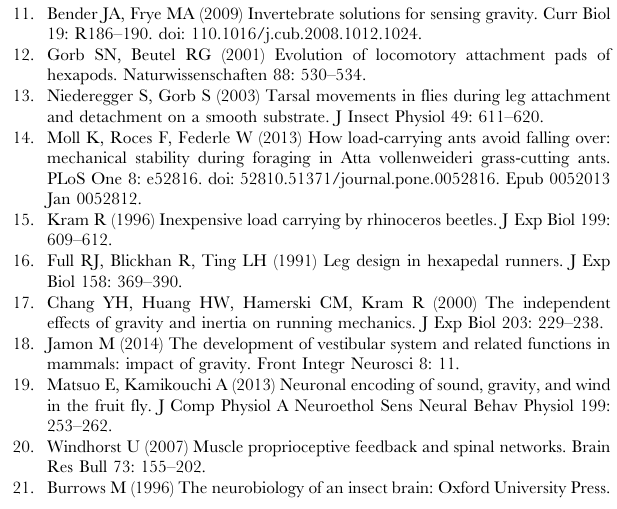
Figure S1 Gait parameters by walking orientation. (A–E) Each column corresponds to a walking orientation compared to upright controls. Graphical fits are also represented. (A) Swing speed. (B) Step length. (C) Swing duration. (D) Stance duration. (E) Duty factor. (TIF) Figure S2 Stance linearity and footprint alignment by walking orientation. Each column corresponds to a walking orientation compared to upright controls. Graphical fits are also represented. (A) Stance linearity. (B) Footprint alignment. (TIF) Figure S3 Footprint clustering by walking orientation. Each column corresponds to a walking orientation compared to upright controls. Graphical fits are also represented. (A–C) Anterior Extreme Position (AEP) clustering. (D–F) Posterior Extreme Position (PEP) clustering. (A, D) Forelegs. (B, E) Midlegs. (C, F) Hindlegs. (TIF) Figure S4 Footprint positions relative to the body center for the different walking orientations. AEP and PEP values for each leg are represented on the left and right sections of the plot, respectively. Values are normalized for body size. Line size denotes standard deviations, while intersection indicates mean value. (A) Inverted. (B) Ascending. (C) Descending. Statistical significance was determined using 2-way-ANOVA with Tukey’s post-hoc tests and post-hoc t-tests, where *p , 0.05; **p , 0.01; ***p , 0.001. (TIF) Figure S5 Interleg coordination indexes by walking orientation. Each column corresponds to a walking orientation compared to upright controls. (A) Tripod index. (B) Tetrapod index. (C) Wave index. (D) Non-canonical index. (TIF) Figure S6 Inter Tripod time and tripod duration by walking orientation. Each column corresponds to a walking orientation compared to upright controls. Graphical fits are also represented. (A) Inter Tripod time (B) Tripod duration. (TIF)